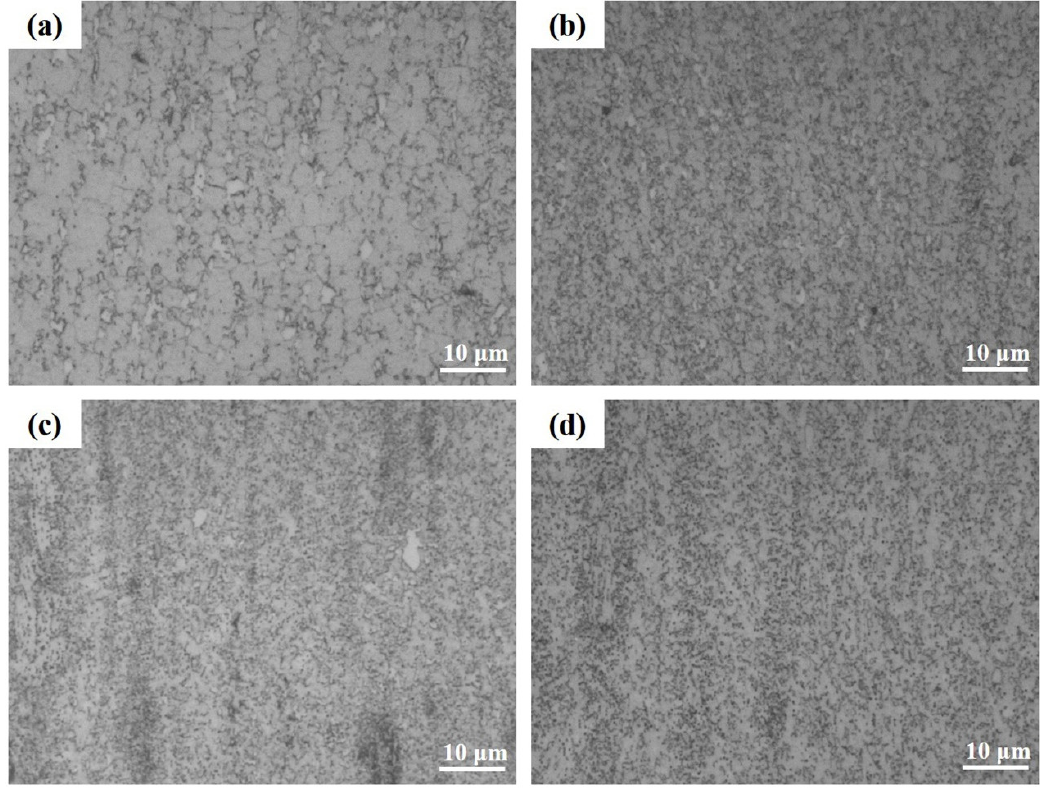
Figure 3. Microstructure of the cross section of AZ91 and AZ91-CaO alloy: ( a ) AZ91-T4-EX, ( b ) AZ91-T6-EX, ( c ) AZ91-CaO-T4-EX, ( d ) AZ91-CaO-T6-EX.